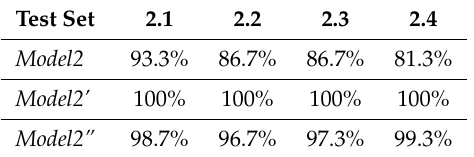
Table 3. Classification accuracies of the models on four colours.